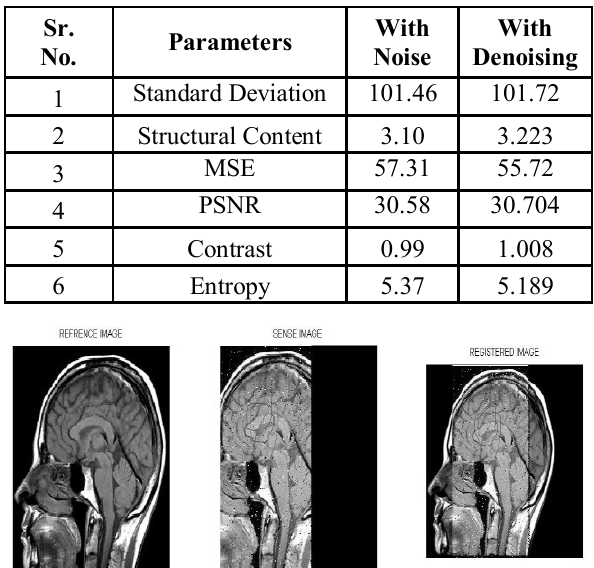
Fig 8. Image Registration for Head CT with Noise